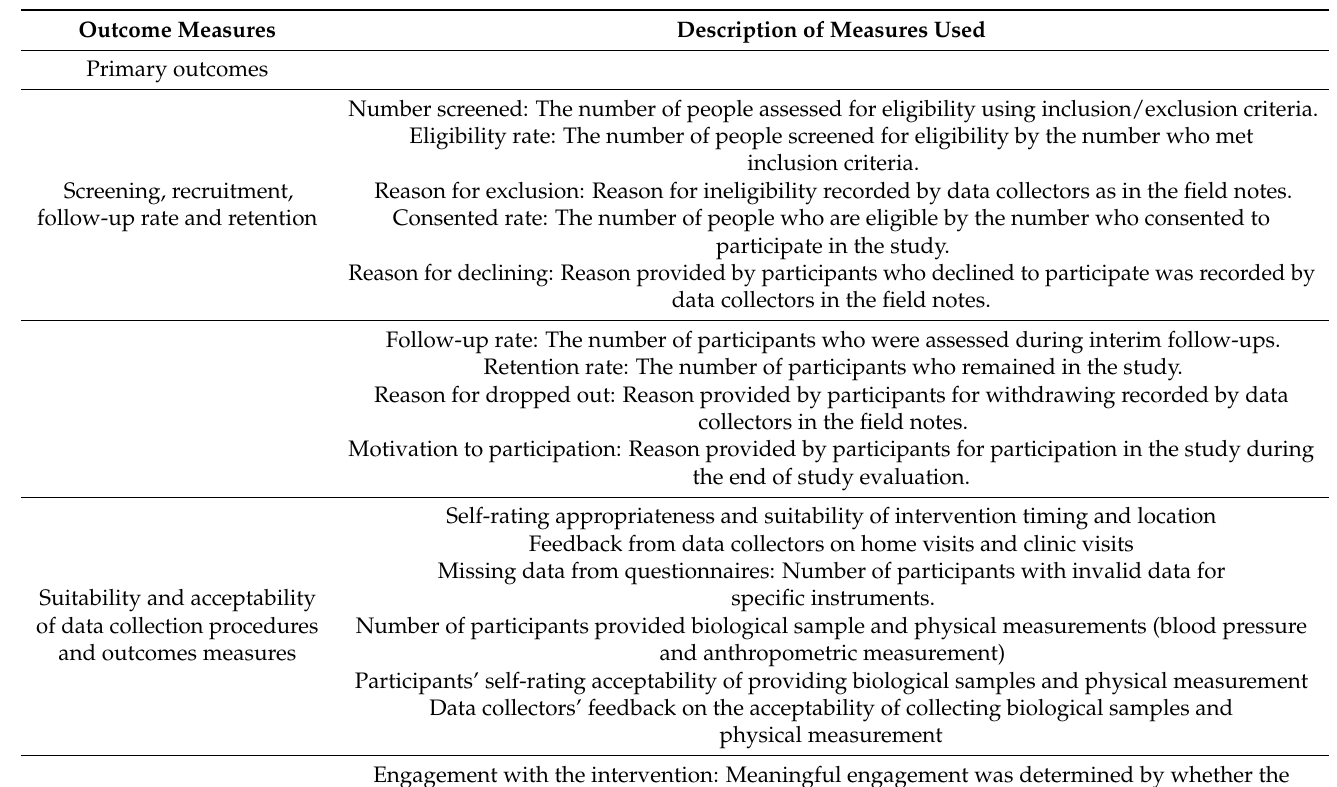
Table A2. The outcome measures for the DePEC-Nutrition feasibility